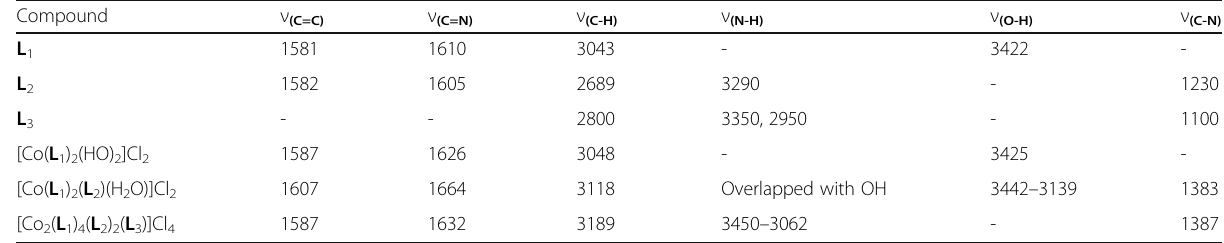
Table 2 Characteristic IR absorption (cm − 1 ) of ligands L 1 , L 2 , and L 3 and complexes 1 , 2 , and 3